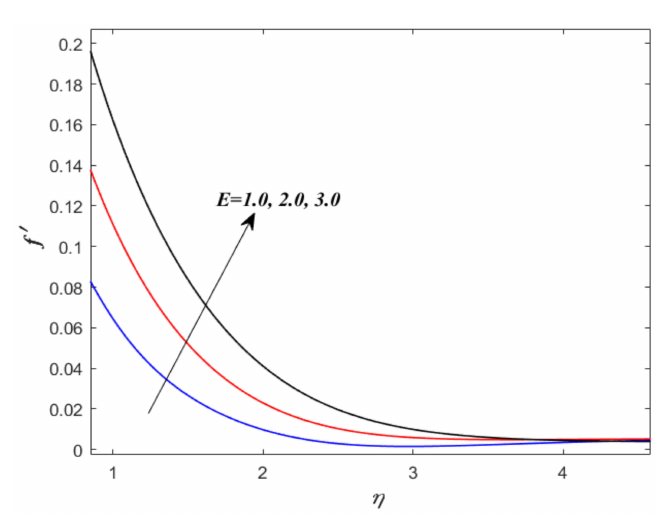
Figure 3. Various values of porous parameter ( K ) on velocity f (cid:48) ( η ) .